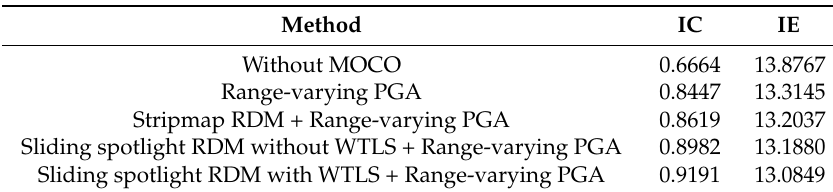
Table 3. IC and IE of the typical area in Figure 8.